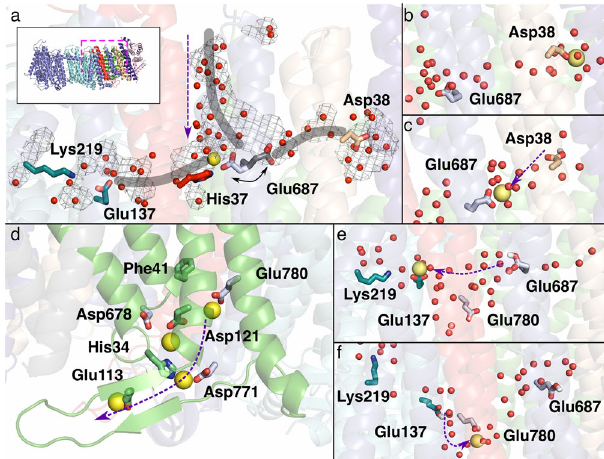
Fig. 6 | MD simulations of sodium transport in Mrp antiporter. a The fl exibility ofGlu687 MrpA allowsittoconnecttothreehydratedpaths(thickgreylines)towards Lys219-Glu137 pair of MrpD, towards Asp38 MrpF , and towards the cytoplasmic side. The vertical purple arrow shows the direction of movement of a possible sodium ion (yellow), bound at Glu687 MrpA , through the hydrated pathway from the cyto- plasmic side. b Sodium modeled near Asp38 MrpF binds to its side chain but is transferred to Glu687 MrpA uponitsprotonation( c ). d Putativesodium release route with sodium ions bound to conserved residues involved in the path. e Protonation of Glu687 MrpA drives sodium to deprotonated Glu137 MrpD , and upon protonation of Glu137 MrpD , sodium is transported further to Glu780 MrpA ( f ) through hydrated